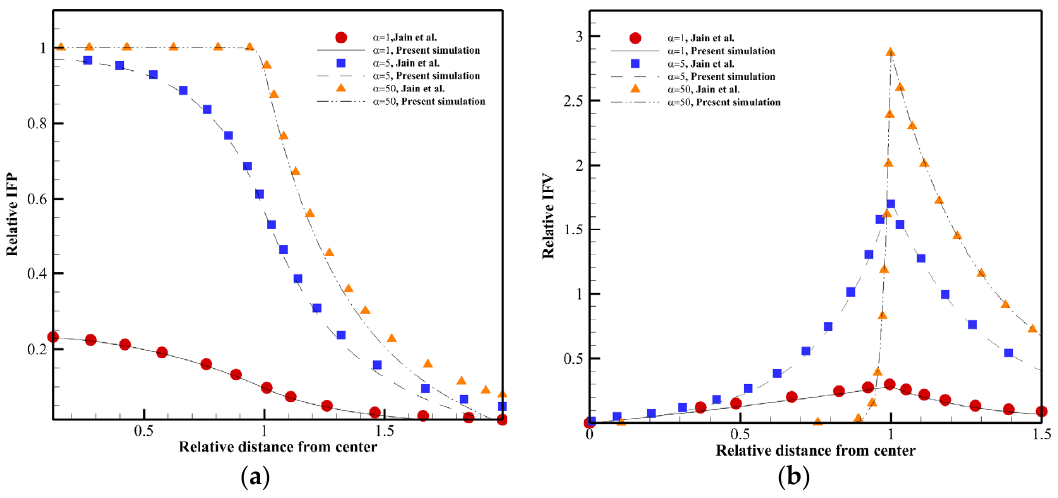
Figure 5. Comparison between the result of the present model and literature [40]. A tumor ( R = 0.4 cm) embedded in the normal tissue is studied in this figure. ( a ) Distribution of the relative IFP. ( b ) Distribution of the relative IFV.